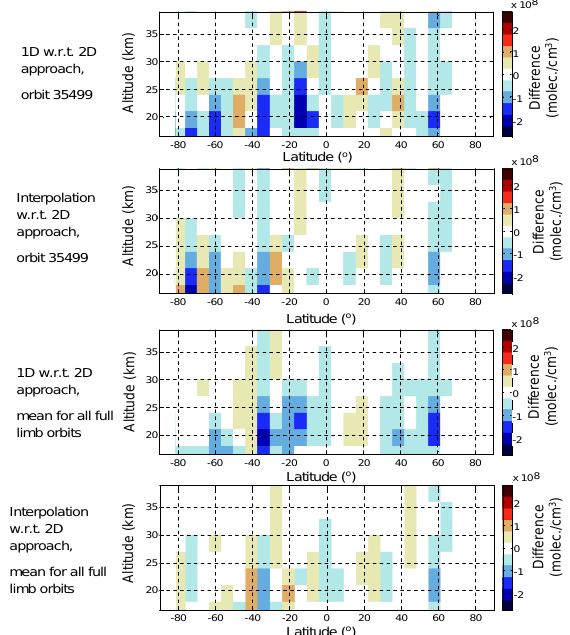
Fig. 7. Differences between the 1-D and 2-D retrieval (plotted for even scanning sequences) are shown in the first and third panel from top in comparison with the differences between the retrieval with interpolation approach (applied for even scanning sequences) and the 2-D retrieval (second and bottom panel). The first two panels show the differences for a single orbit (34599), the remaining panels the differences for the mean of all full limb orbits.